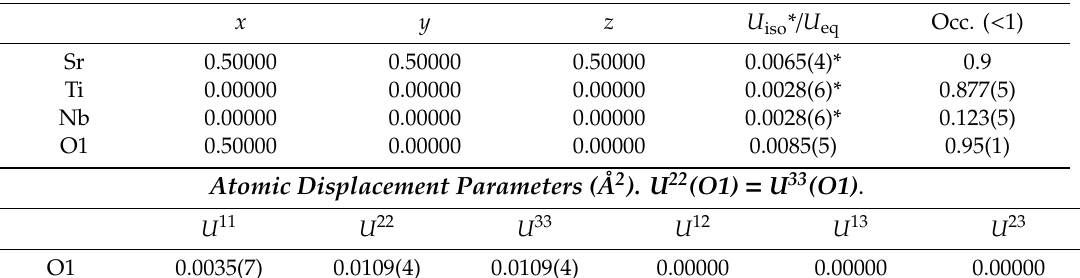
Figure 2. View of the crystal structure of Sr 0.9 (Ti 0.9 Nb 0.1 )O 3 at 800 ◦ C, highlighting the anisotropic ellipsoids for O atoms (99% probability), shaped as disks perpendicular to the Ti(Nb)-O-Ti(Nb) chemical bonds. Table 1. Structural parameters after the Rietveld refinement of Sr 0.9 (Ti 0.9 Nb 0.1 )O 3- δ from NPD data at 25 ◦ C in the Pm-3m space group, a = 3.91726 (4) Å, with λ = 1.051 Å. Discrepancy factors: R p = 3.14%, R wp = 4.27%, R exp = 2.49%, R Bragg = 3.14%, χ 2 = 3.27.